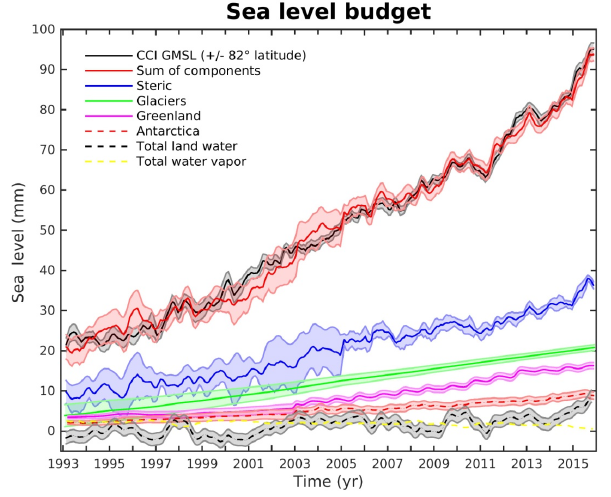
Figure 10. Differences between individual GMSL time series and ensemble mean GMSL (average of the 6 products) over Jan- uary 1993–December 2015 (adapted from Dieng et al.,